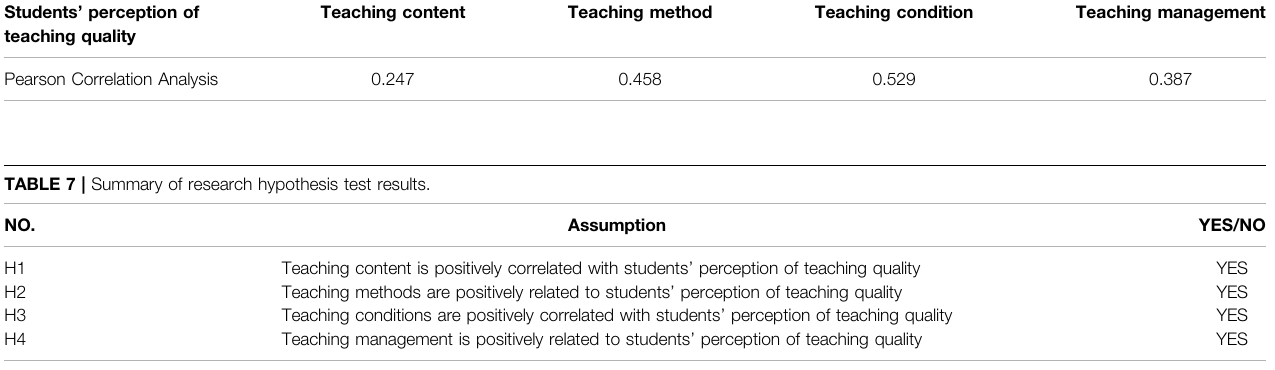
TABLE 6 | Correlation analysis between students ’ perception of teaching quality and various dimensions. Students ’ perception of teaching quality